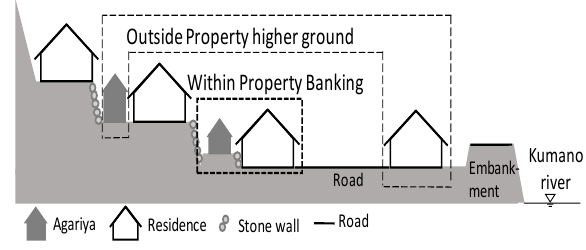
Figure 8. Arrangement of house and